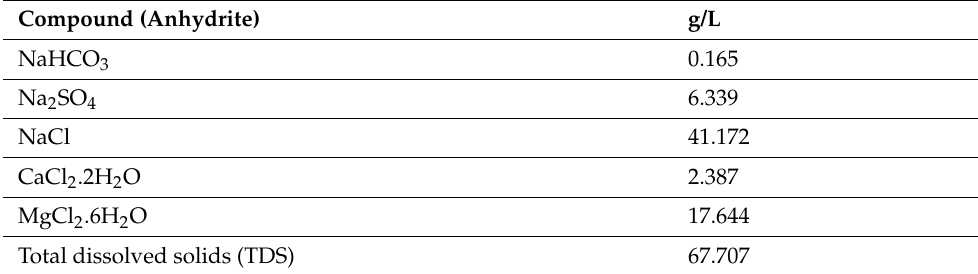
Table 1. SW formulation used in the